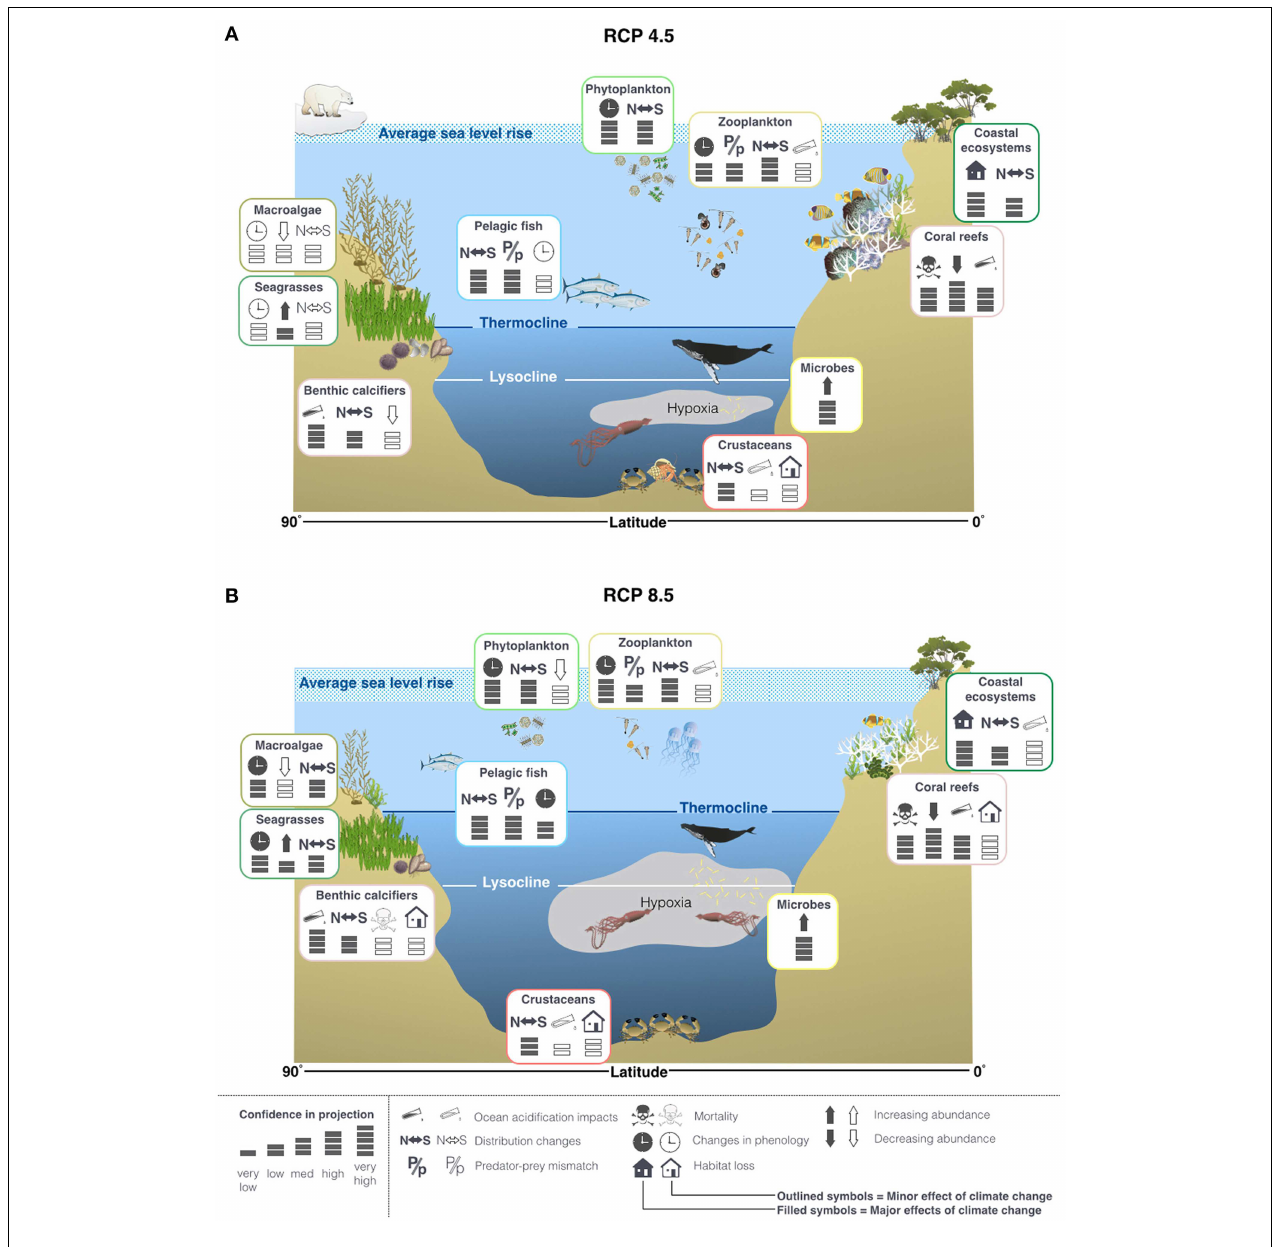
FIGURE 8 | Projected changes to physical features in the oceans and some of the potential impacts on life in the oceans under RCP4.5 (A) and 8.5 (B), based on the findings reported in the IPCC AR5 and literature published since the cut off dates (15/03/2013 for working group I and 31/08/2013 for working group II). It is projected that thermocline and lysocline will shoal to a greater extent and OMZs will expand more under RCP8.5 compared to